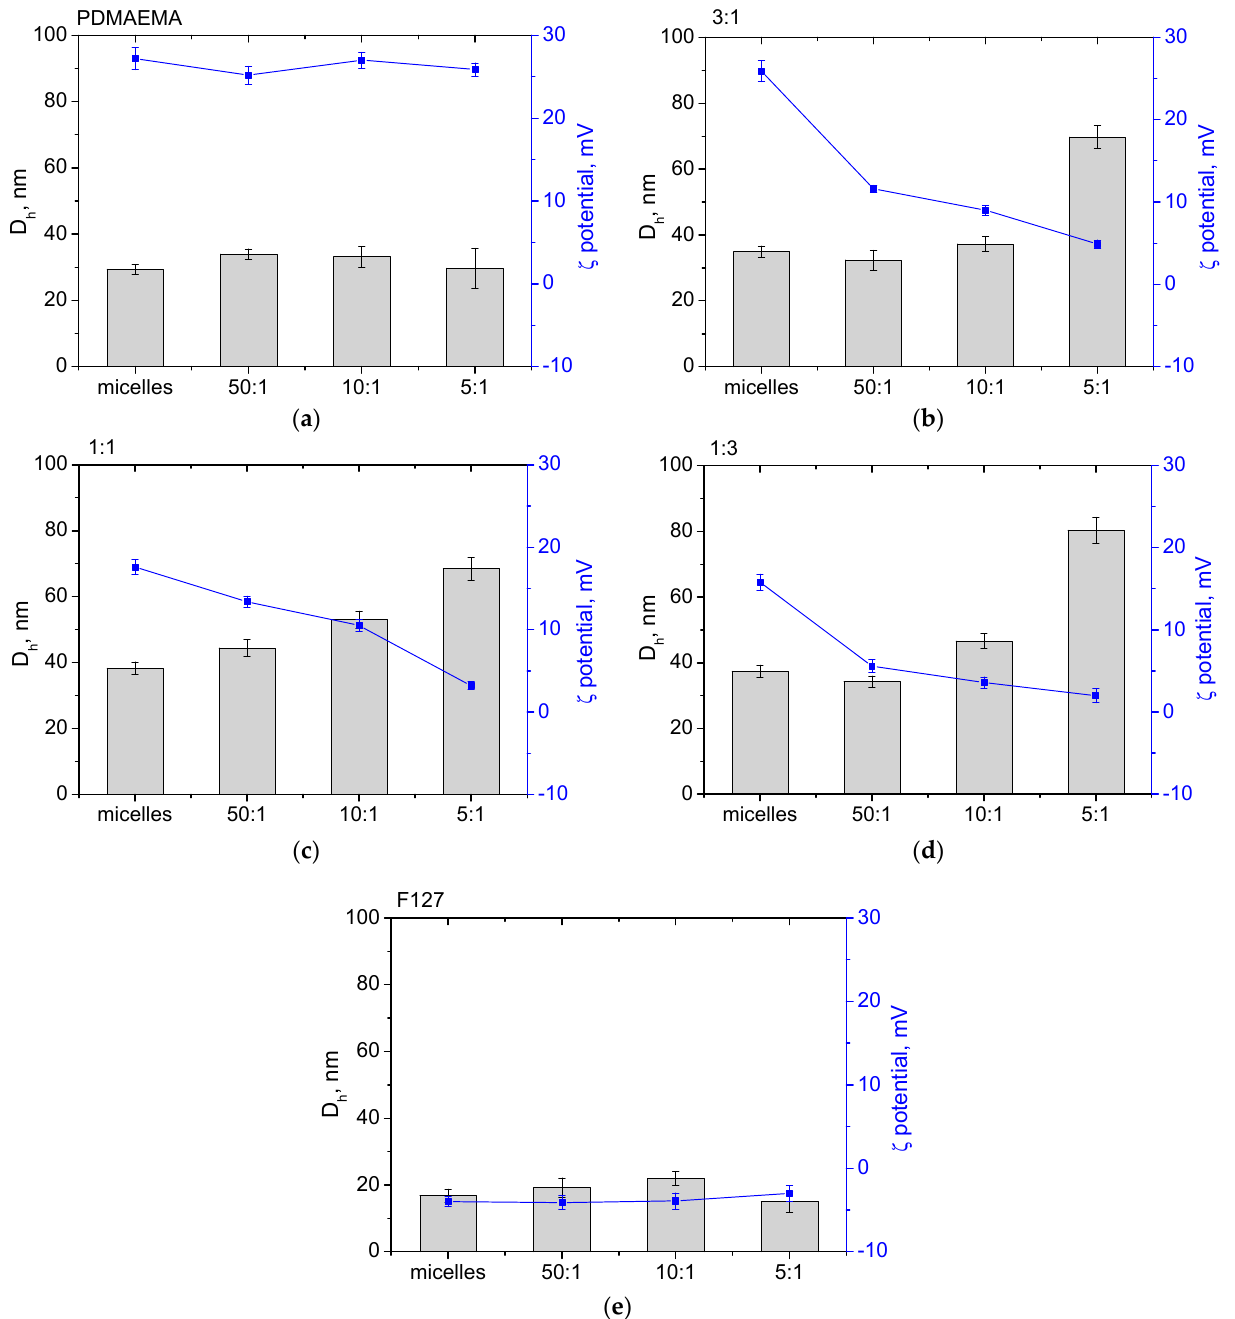
Figure 3. Variations of the hydrodynamic diameter, D h , (grey columns) and ζ potential (blue symbols) with the polymer-to-drug mass ratio of SCPMs ( a , e ) and MPMs ( b – d ) based on PDMAEMA-b-PCL-b-PDMAEMA and Pluronic F127 triblock copolymers. Measurements were conducted at 25 °C at pH 7. Each data point represents the arithmetic mean ± SD of three separate experiments.